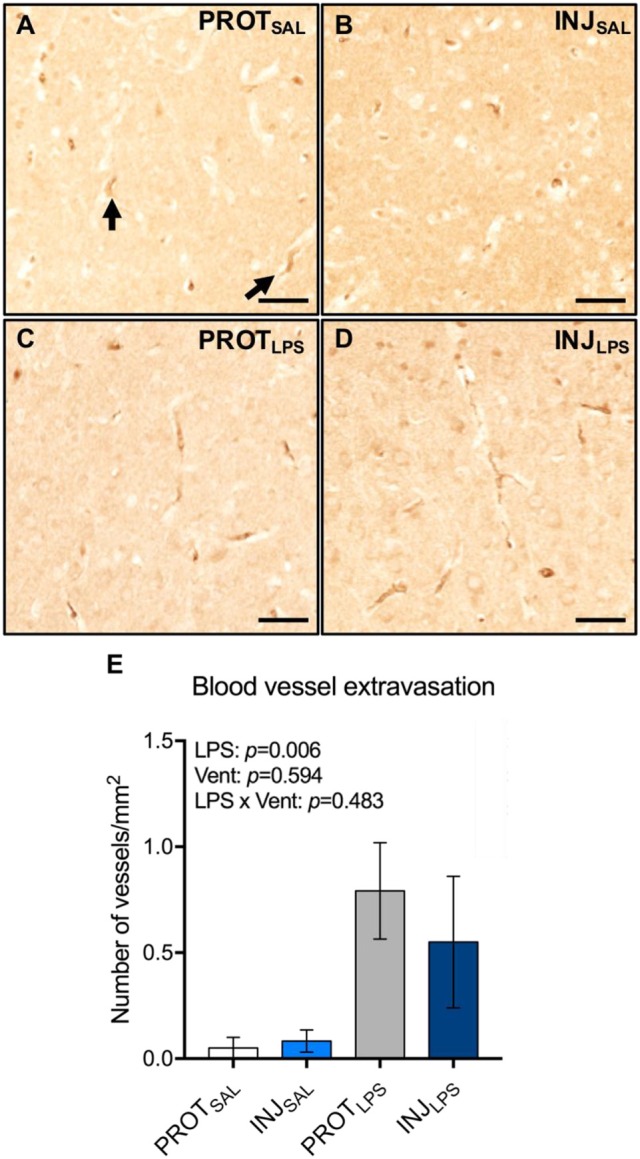
LPS exposure is associated with vessel protein extravasation in the cortical gray matter. Representative images of blood vessels labeled for sheep serum in the gray matter (A–D). LPS exposure leads to an increase in the number of blood vessels with protein extravasation (E). Magnification = 4x, scale bar = 20 μm. PROTSAL, N = 5; PROTLPS, N = 6; INJSAL, N = 6; and INJLPS, N = 5.